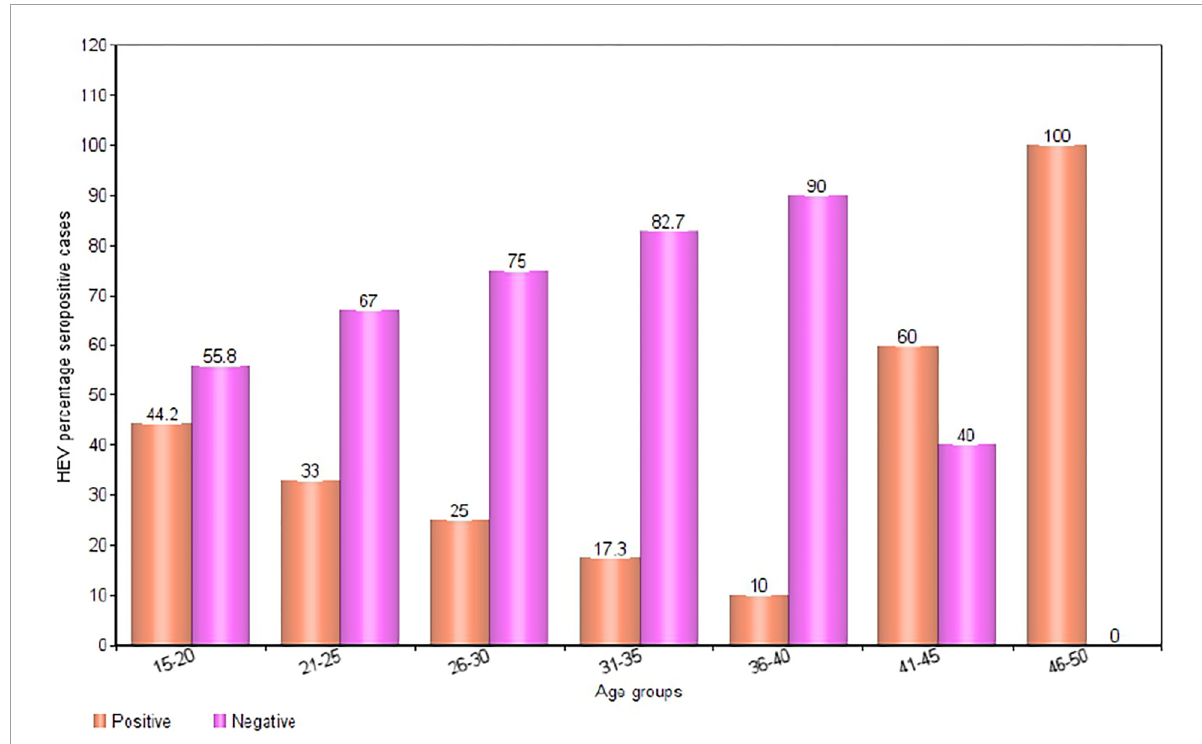
FIGURE2 Bar chart showing the age-specific seropositivity of HEV in pregnant